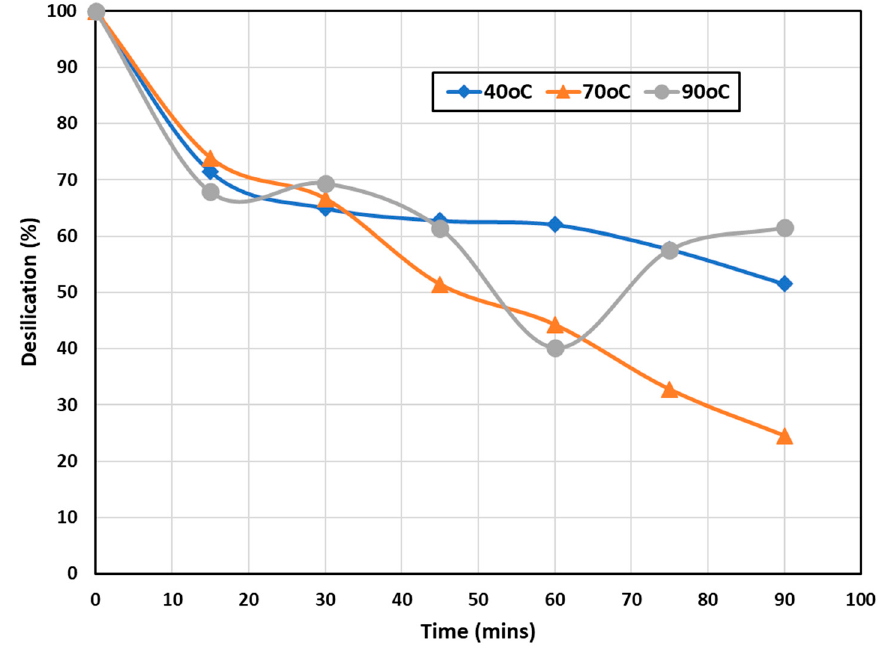
Figure 5. Percentage reduction of Si with time using 4 g CaO at temperatures 40 °C (Test 6), 70 °C (Test 3), and 90 °C (Test 7).